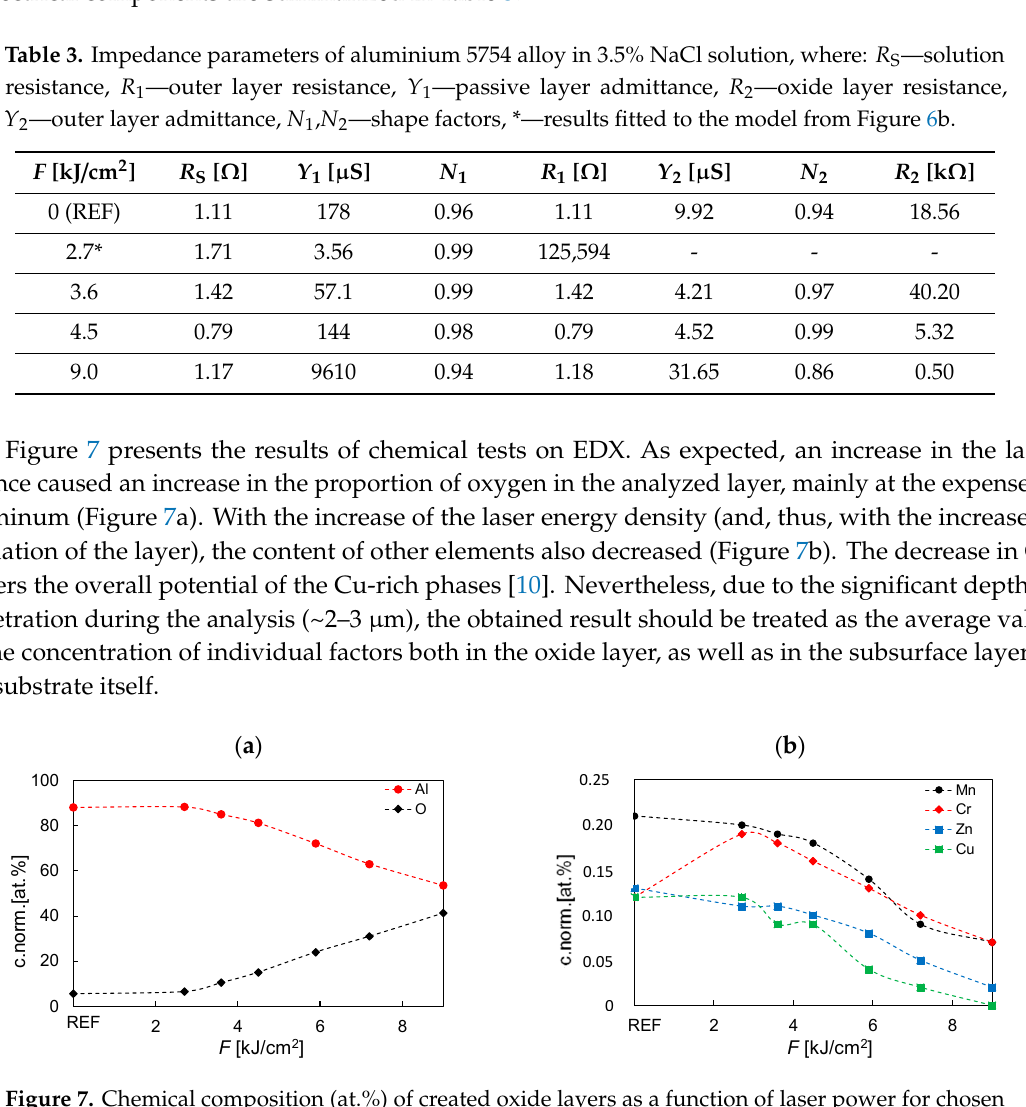
Figure 7. Chemical composition (at.%) of created oxide layers as a function of laser power for chosen elements: ( a ) aluminum and oxide, ( b ) manganese, chrome, zinc, and copper.